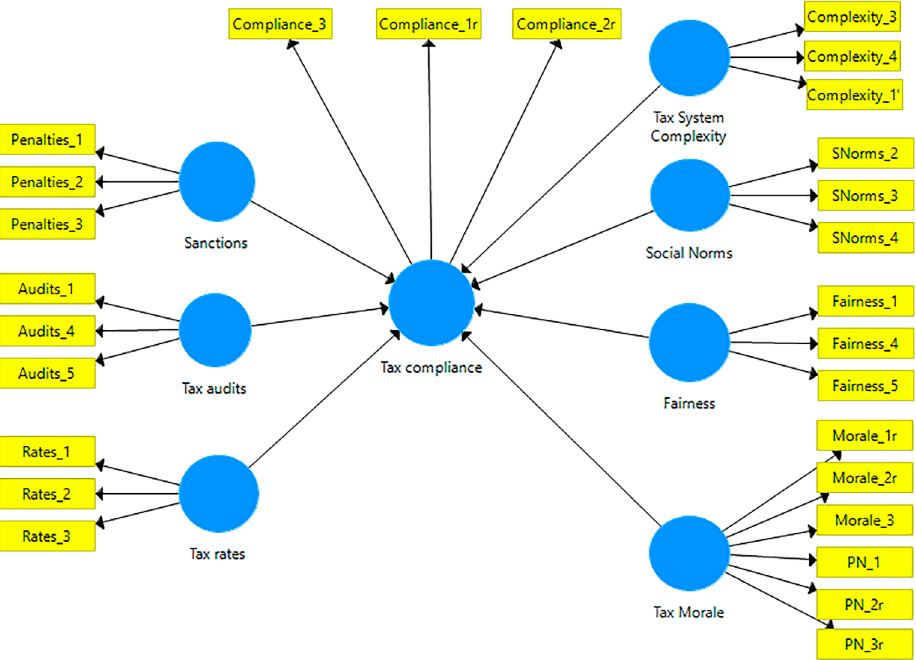
Figure 1. Croatian Tax compliance model